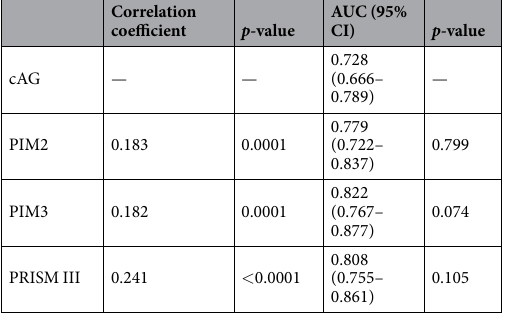
Table 4. Correlation and AUC comparison between cAG and pre-existing mortality prediction models in PICU. AUC, Area under the receiver operating characteristic curve; CI, confidence interval; cAG, corrected